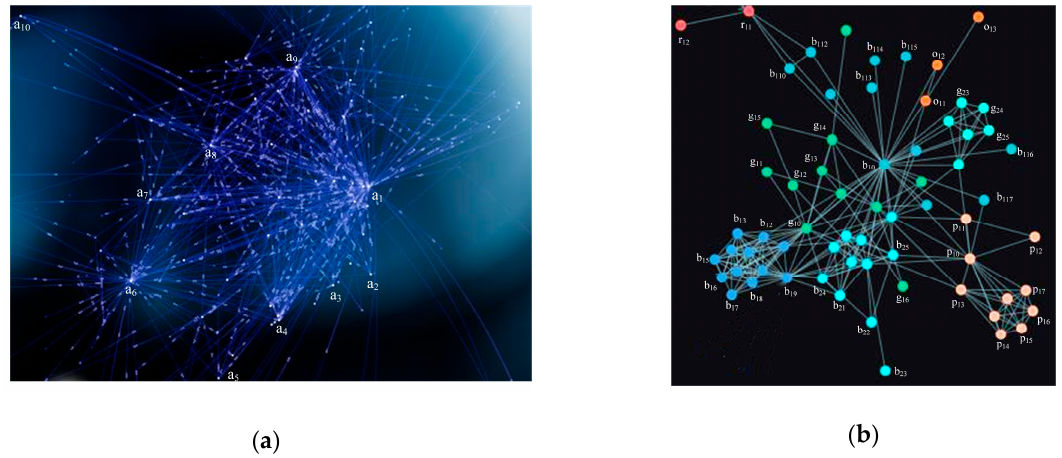
Figure 9. ( a ) Migration map and ( b ) force-directed graph illustrating that they can realize traceability analysis of the unqualified products. Table 2. Parameters of the unqualified products .